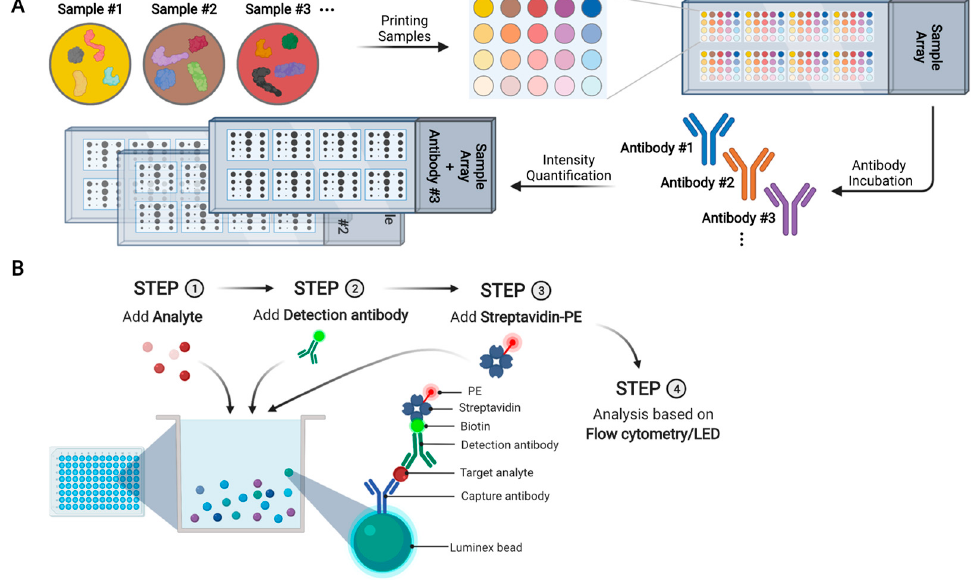
Figure 8. Schematic overview of reverse phase protein array (RPPA) and Luminex microsphere bead capture. ( A ) Schematic of RPPA. Each spot contains a single sample and each array is probed with one specific antibody. The bound antibody can be quantified (either directly or indirectly) by fluorescent, colorimetric, or chemiluminescent assays. ( B ) Schematic of Luminex microsphere bead capture assay. Analyte-specific capture antibodies are immobilized on superparamagnetic microsphere beads that are color-coded. After incubating a test sample with antibody-coated microsphere beads, target proteins are captured. Biotinylated detection antibodies specific to the target proteins are added, leading to the formation of an antibody–antigen sandwich. Phycoerythrin (PE)-conjugated streptavidin is added, so that the protein amount can be quantified based on the intensities of PE-derived signal.